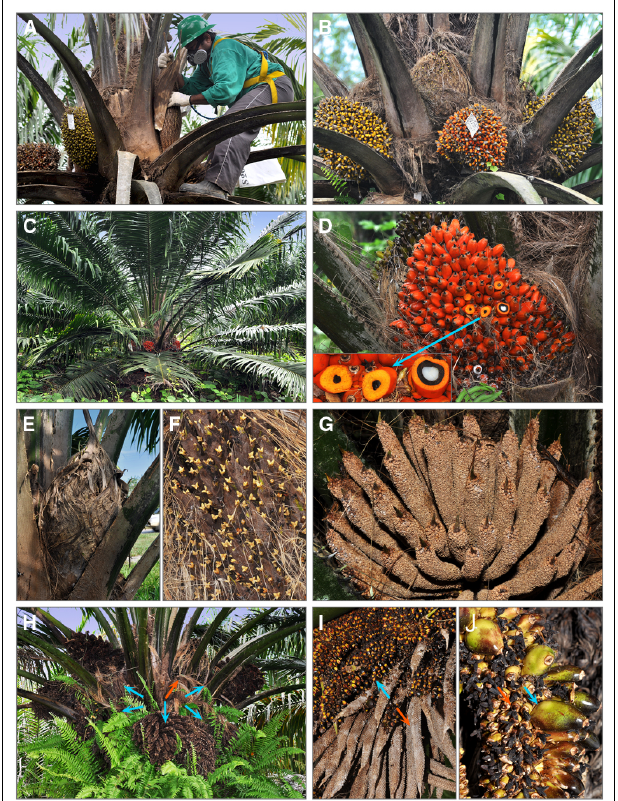
FIGURE 2 | E. oleifera (cid:2) E. guineensis interspecific hybrids at EMBRAPA breeding station Rio Urubu (Amazonas, Brazil). (A) Controlled pollination. Worker is removing the spathe on elite E. oleifera tree that is three meters tall. He wears safety gear to climb the tree, protective mask and gloves. In commercial seed production, female inflorescences are bagged 1 week before anthesis. (B) Bunch ripening. Three bunches at different times after pollination are visible. As fruit mature, the fruits change color from green to orange. The youngest female inflorescences were not used in pollination, those bunches are still enclosed in spathe, which is an E. oleifera species-specific characteristic. (C) F1 interspecific hybrid on commercial plantation. Tree is 4 years old. It has about twice shorter stem than African oil palm trees of the same age. Orange mature bunches are easily spotted within the tree crown. (D) Parthenocarpic fruits in mature bunch of the F1 interspecific hybrid. Insert: a few fruits were transversely cut. The fruit to the right has normal seed. White colored endosperm tissue of the kernel is surrounded by the black endocarp, mesocarp is orange. Parthenocarpic fruits have residual black endocarp and no kernel. (E) Female inflorescence of F1 hybrid at anthesis. Inflorescence is still enclosed in spathe, which is similar to the parent E. oleifera. (F) Female flowers. The same inflorescence as in (E) . Spathe was removed to show female flowers at anthesis. Three-lobed flower stigmas are yellowish in color and receptive for pollen. (G) Male inflorescence of F1 hybrid at anthesis. The overall morphology and flower identity are normal. (H) Andromorphic inflorescences. This 15-years-old tree developed five fully andromorphic inflorescences pointed with blue arrows and a single male inflorescence (behind the leaf rachises to the right). Orange arrow points a fruit bunch. (I) Partial andromorphy. Individual andromorphic inflorescence can show different proportions of male flowers (orange arrow) and female flowers (blue arrow). (J) Fruitlets from andromorphic inflorescence. Some fruitlets abort after anthesis, died dry flower pistils are black (orange arrow), other develop parthenocarpically (blue arrow). Andromorphic inflorescences in (H) are full of developing